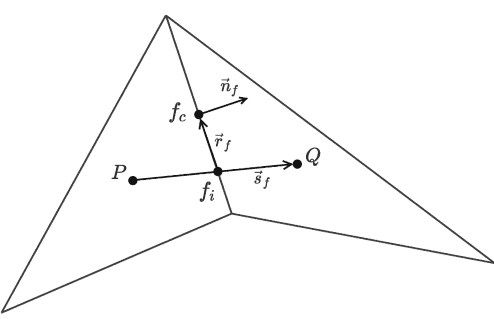
Figure 1. Non-orthogonal and skew cells; 𝑷 and 𝑸 are the centers of each cell, 𝒇 𝒄 is the face centroid, 𝒇 𝒊 is the face interpolated value, and 𝒏(cid:4652)(cid:4652)⃗ 𝒇 is a normal of face 𝒇 .